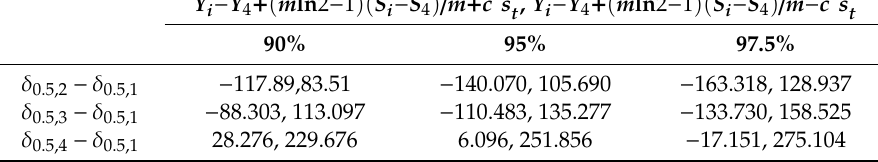
Table 5. The 90%, 95% and 97.5% two-sided confidence intervals for three categories compared with the control category (Category